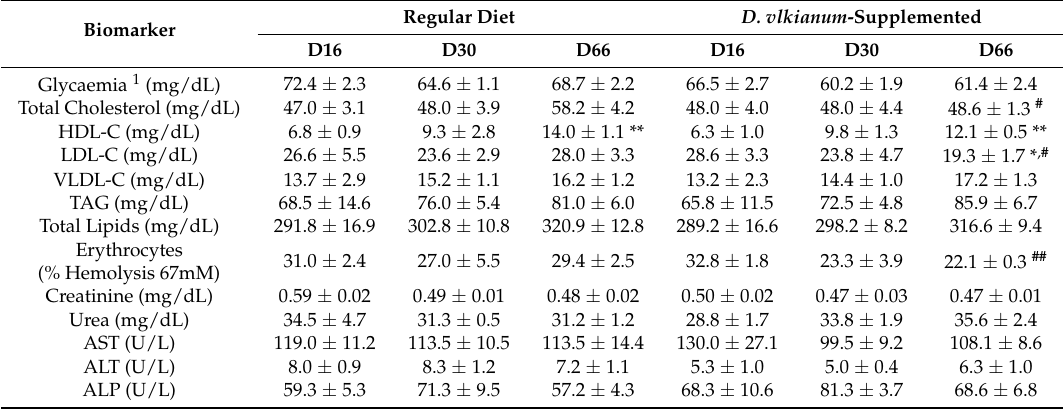
Table 2. Effect of Diacronema vlkianum biomass supplementation on rat’s plasma biomarkers, glycaemia and erythrocytes